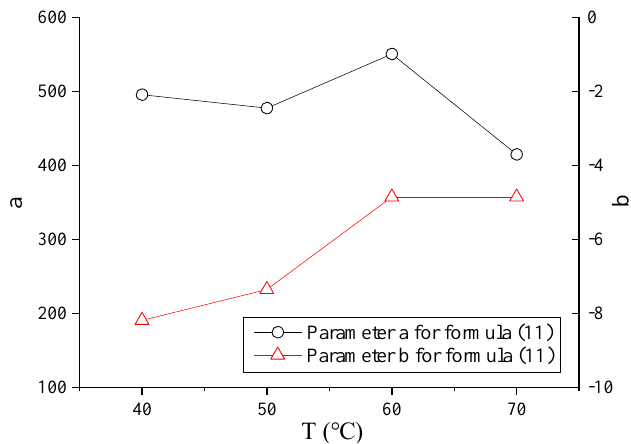
Figure 18. Parameters of the instability prediction model at different temperatures.